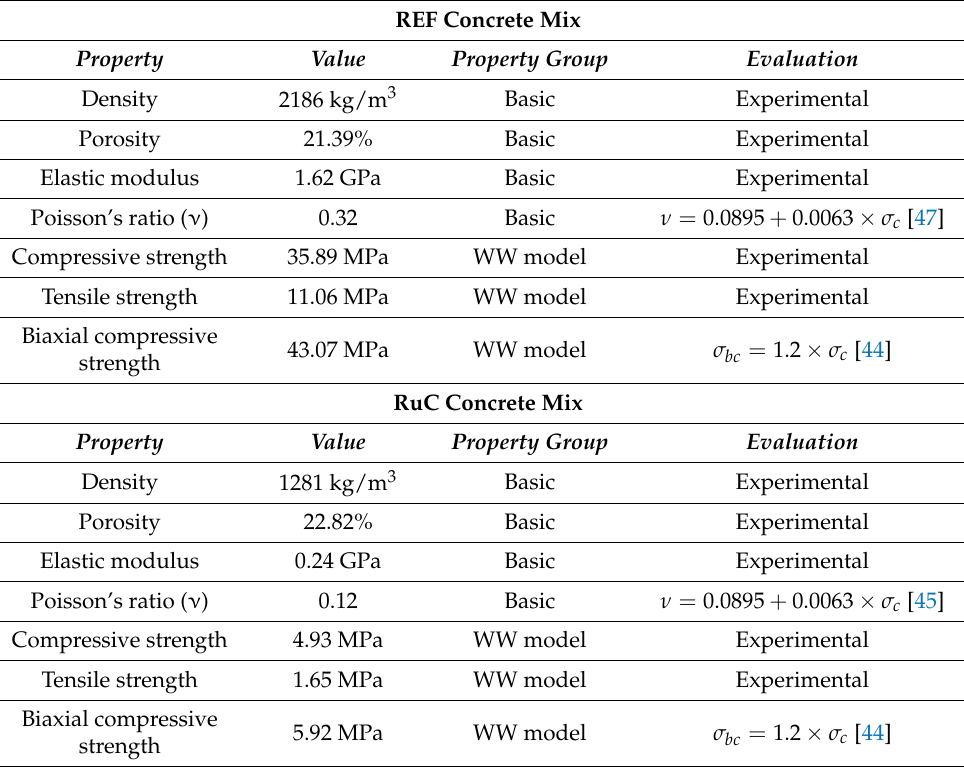
Table 7. Material input properties for FEA-based mechanical investigation on brick